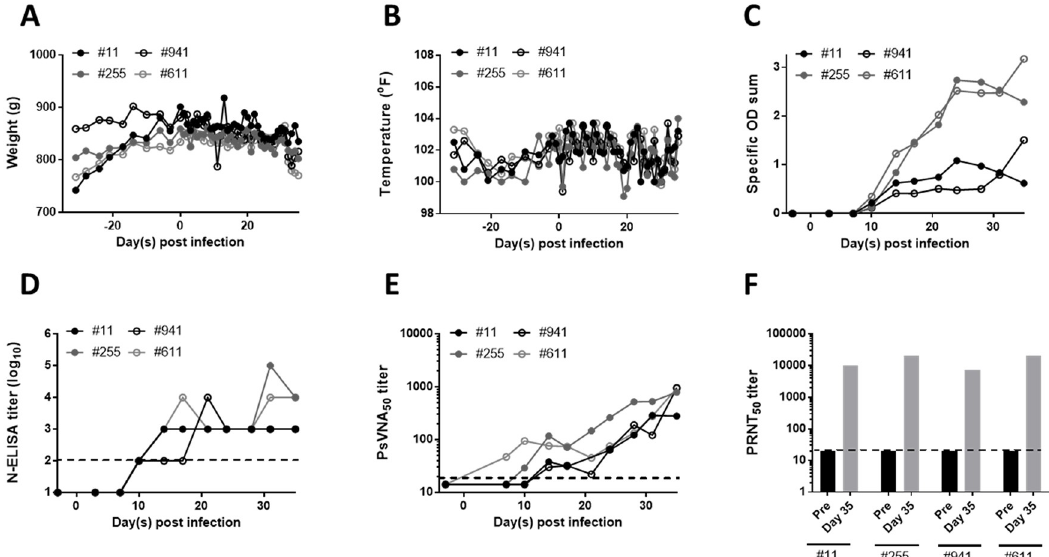
Fig 6. PUUV infected ferrets experience weight loss, but no other clinical signs of infection. Ferrets were infected with 94,000 PFU PUUV Beaumont i.m. and sera was collected twice weekly. Weight (A), temperature (B), N-ELISA specific OD sum (C), N-ELISA titer (log 10 ), (D) PsVNA 50 titers (E), and PRNT 50 titers (F). The dotted line represents the limit of dectection for the PRNT assay (20), the PsVNA assay (20) and the N-ELISA (2log 10 ).